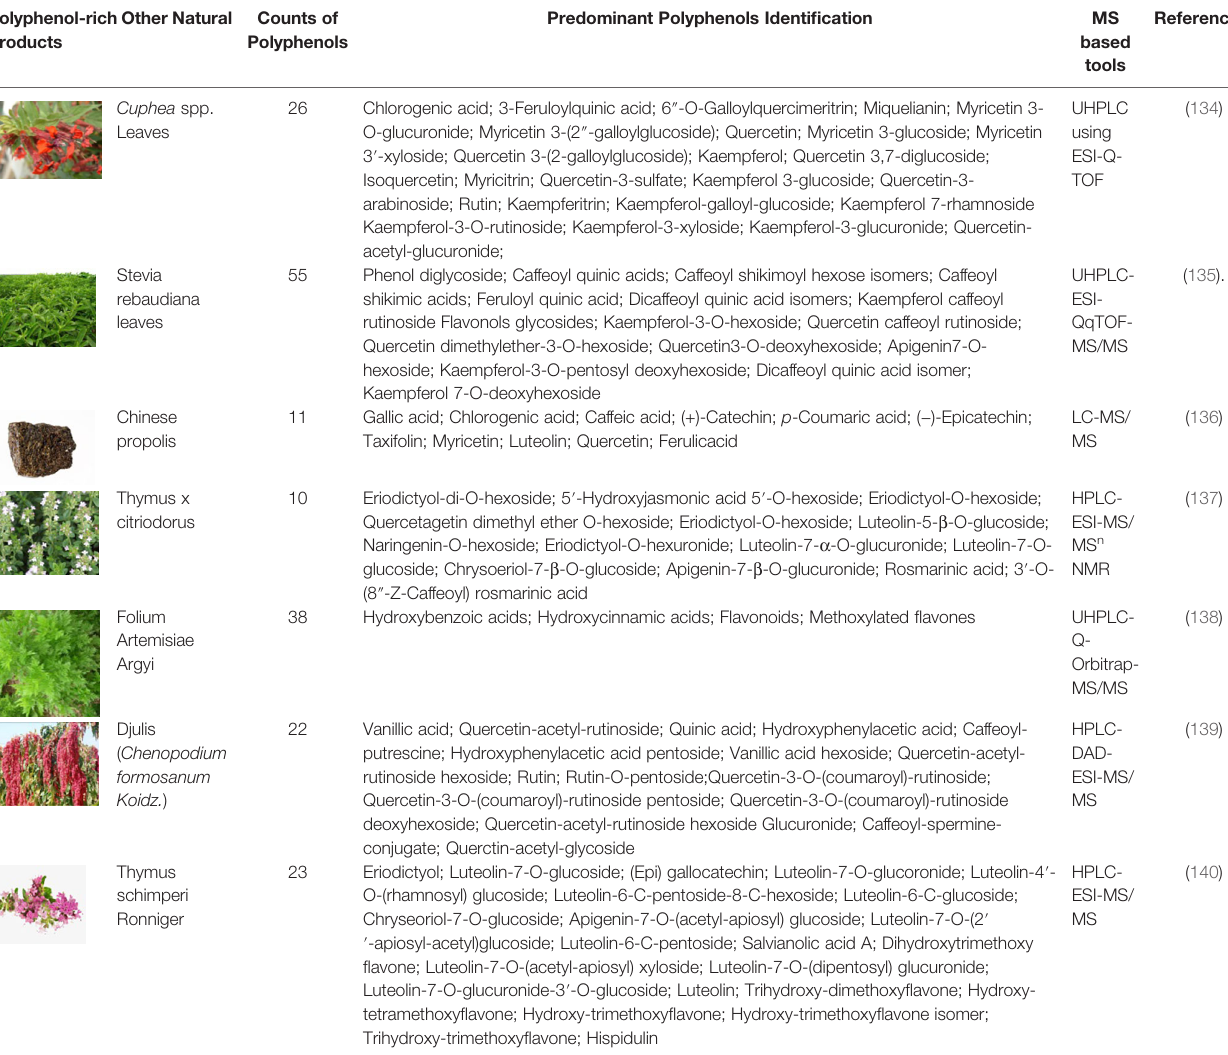
TABLE 1-4 | MS-based foodomics applied to the determination of polyphenolic active compounds in other natural products. Polyphenol-rich Other Natural